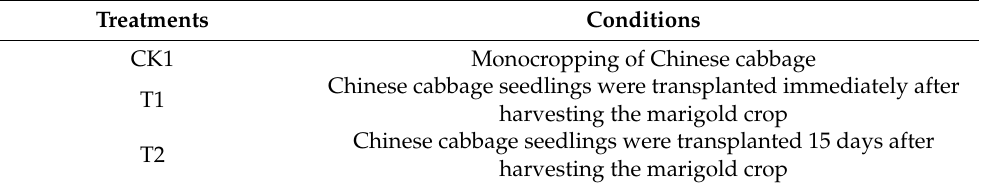
Table 4. Experimental